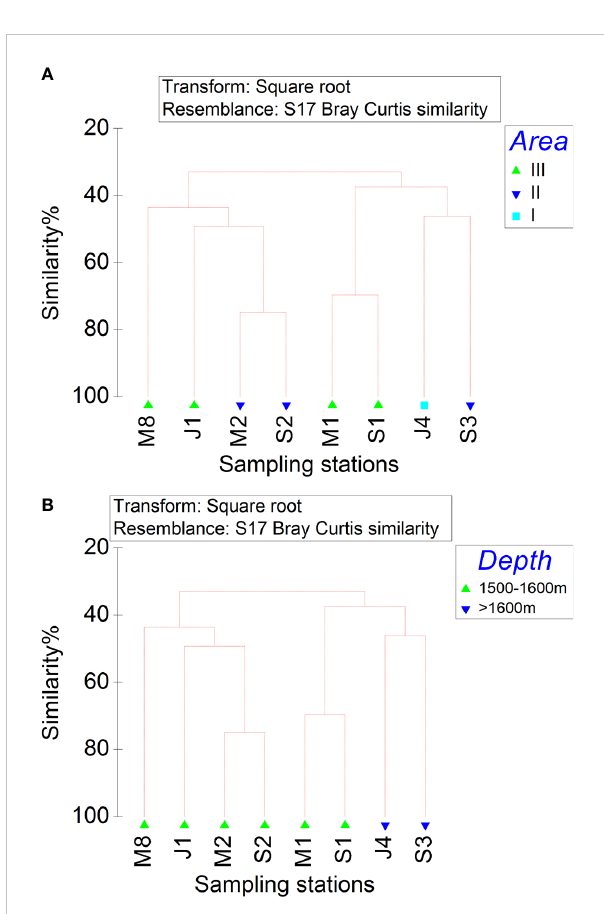
FIGURE 3 Species composition of marine tardigrade fauna at all stations in the deep South China Sea based on CLUSTER analysis. (A) Area factor, (B) Depth